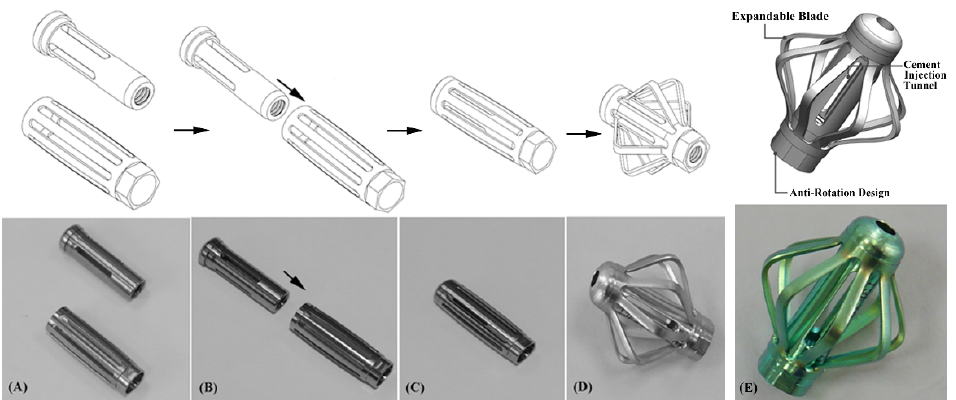
Figure 2. Schematic drawing (upper) and photograph (lower) showing the EVA ® device. ( A ) EVA ® including a rigid tube component and a barrel component before assembly; ( B ) assembling the tube into the barrel; ( C ) after assembly of tube and barrel (unexpanded EVA ® ); ( D ) expanded EVA ® ; and ( E ) following the expansion of EVA ® using an operation device, the barrel component forms eight expanded blades capable of providing structural support to the bone tissue, and the tube tunnel allows cement to be injected through its central tunnel.